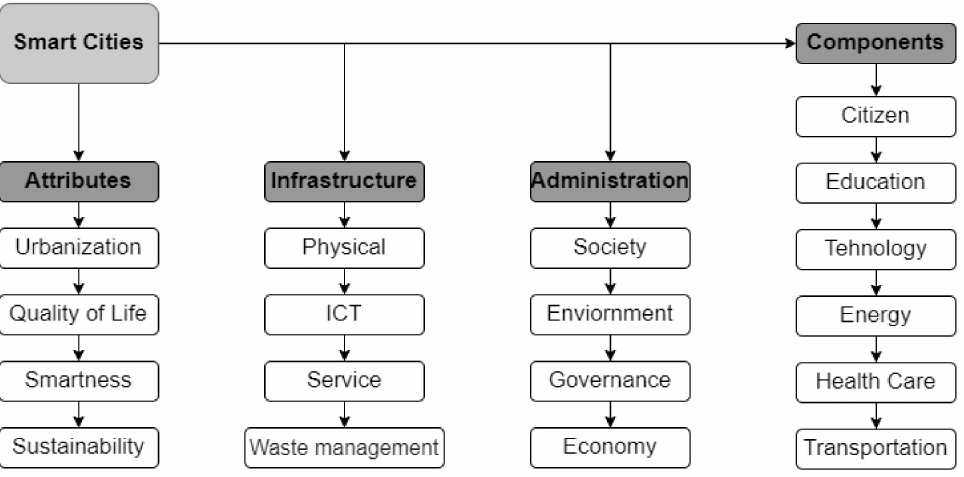
Figure 3. Smart City components included in digitalization